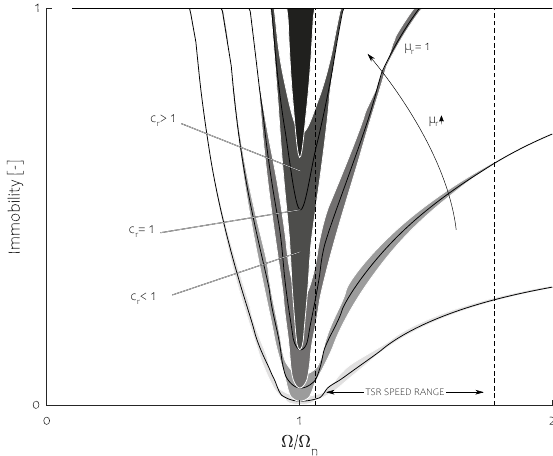
Figure 10. Influence of damping and rolling friction on balance immobility for a nominal initial unbalance of G 20. Damping c r = { 0.5;0.6;1;1.4 } . Friction µ r = { 0.25;0.5;1;2;5 } .